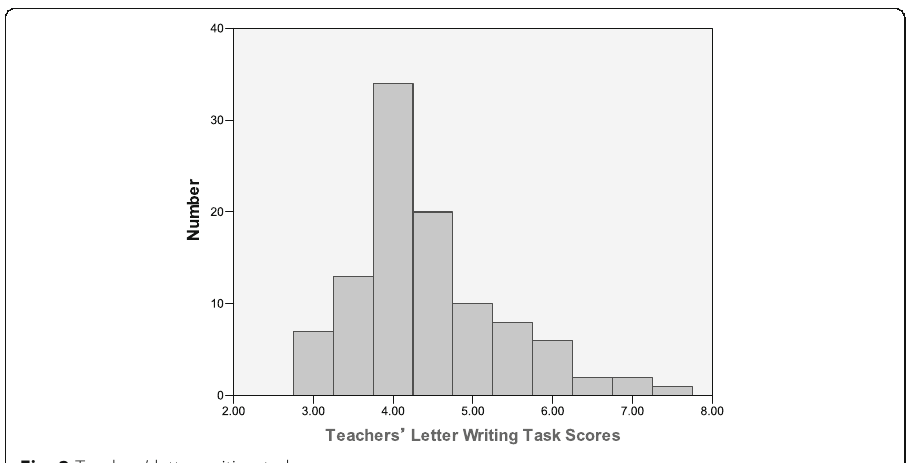
Fig. 2 Teachers ’ letter writing task scores